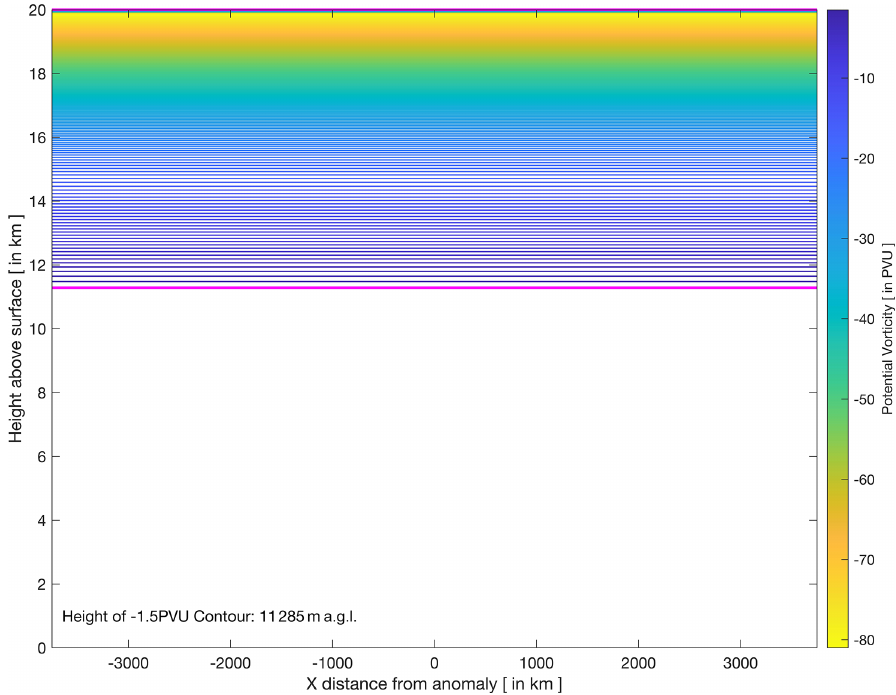
Figure 2. PV zonal cross-section through the centre of the domain. The − 2PVU tropopause was specified at a height of 12500 ma.g.l. The − 1.5PVU contour (highlighted by a thick magenta line) was calculated to be 11285ma.g.l. A contour interval of 0.5PVU is used.